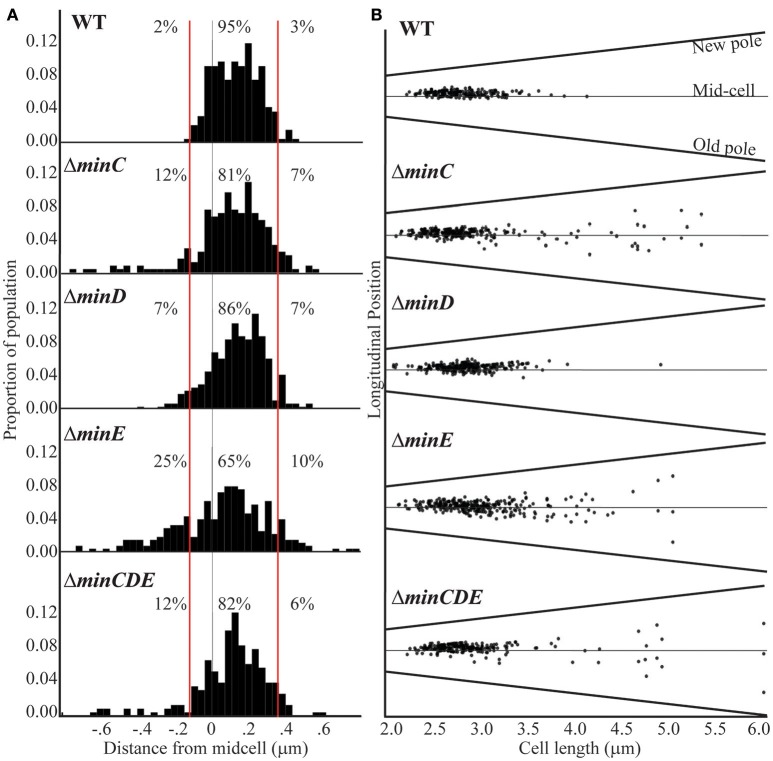
Cell constriction placement in wildtype and min mutant cells. (A) Histograms of constriction position relative to distance from the midcell (gray line; relative position = 0). The red lines at −0.1 and 0.35 μm mark the region where constrictions typically form in wildtype cells. Negative numbers are closer to the old pole whereas the positive numbers are closer to the new pole. Percentages indicate the proportion of constrictions placed farther than −0.1 μm from mid-cell, placed between −0.1 and 0.35 μm, and placed more than 0.35 μm from mid-cell. (B) The longitudinal position of constrictions is plotted against cell length. For this analysis, cells are ordered by cell length and black dots indicate the position of the constriction. Mid-cell is indicated by the center gray line and the slanted lines indicate the position of the new and old pole for each cell. For these analysis, the predivisional cells within a population of ~1,000 cells were analyzed (n = 186 for wildtype; n = 242 for ΔminC, n = 262 for ΔminD, n = 285 for ΔminE, and n = 225 for ΔminCDE).